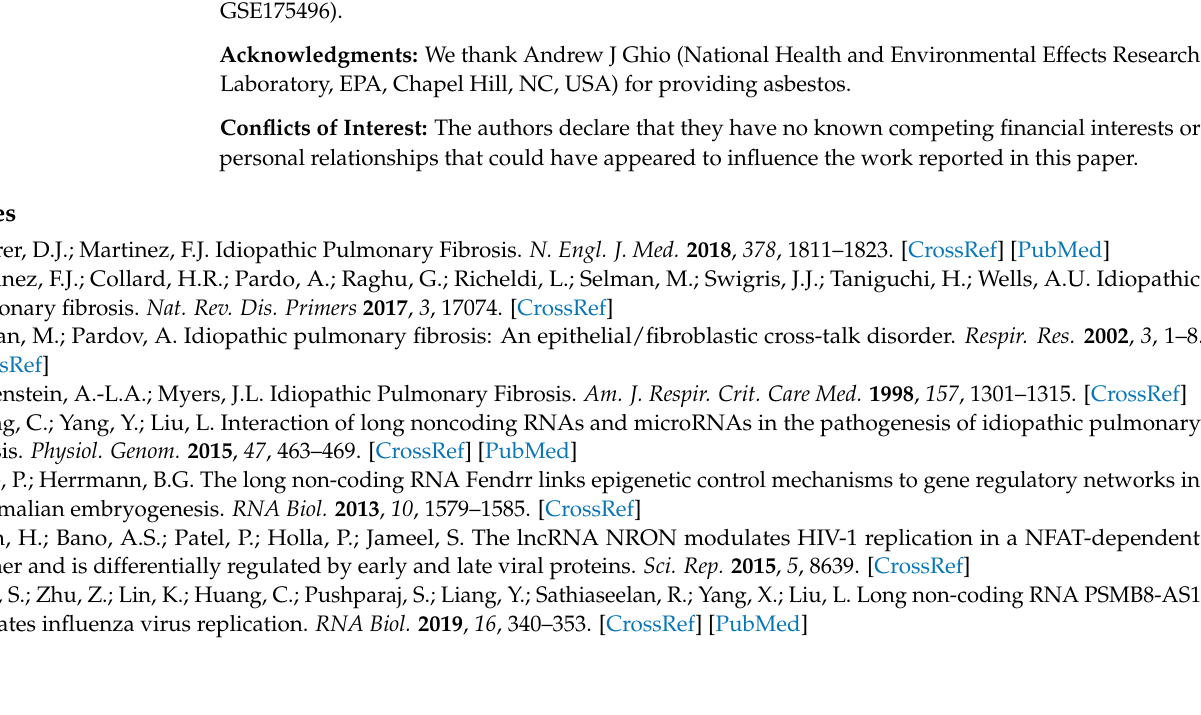
Silencing of SRSF9, Figure S2: Silencing of β -catenin, Figure S3: FENDRR reduced asbestos-induced lung fibrosis, Figure S4: Differentially expressed genes in the lung tissues of crocidolite- and FENDRR - treated mice, Figure S5: Functional annotation of crocidolite-up-regulated and FENDRR -down- regulated genes, Table S1: Crocidolite up-regulated and FENDRR down-regulated genes, Table S2: Biological processes of crocidolite up-regulated and FENDRR down-regulated genes, Table S3: Cellular components of crocidolite up-regulated and FENDRR down-regulated genes, Table S4: KEGG analysis of crocidolite up-regulated and FENDRR down-regulated genes. Table S5: